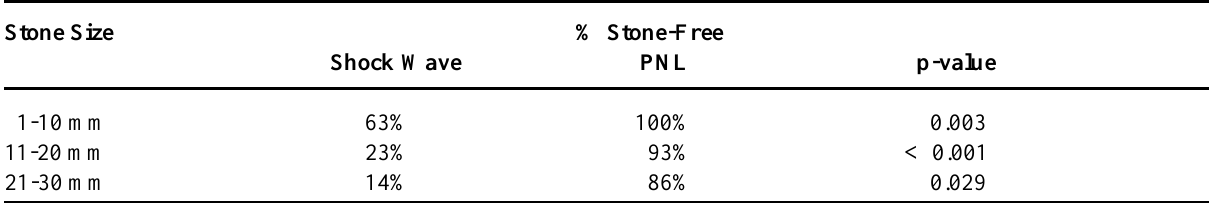
Table 2 - Comparison of stone-free rates for lower pole calculi, shock wave lithotripsy versus percutaneous nephrolithotomy. Stone